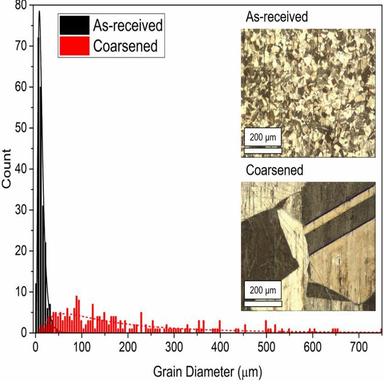
Grain diameter histograms for the as-received and annealed Ni specimens (>200 data points from each specimen), characterised from optical micrographs. Curve is the lognormal of the data distribution. Inset optical micrographs showing the differing grain sizes and character.